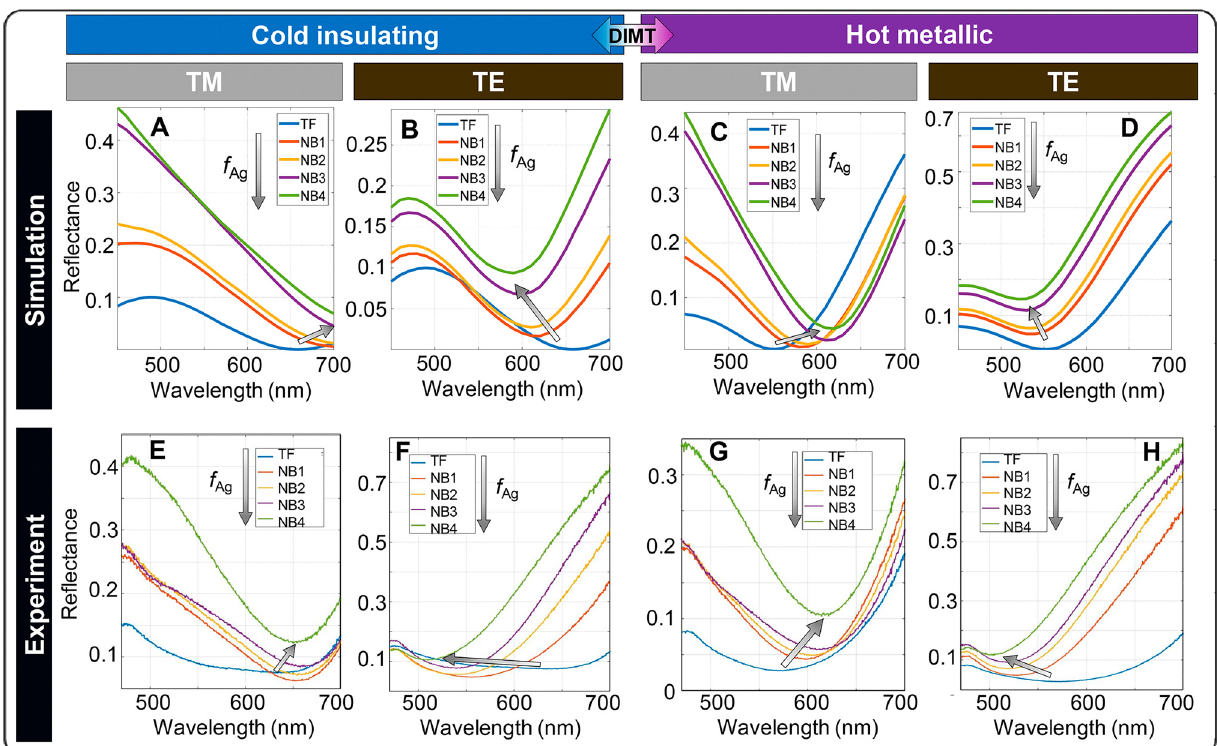
Figure 4: Effects of Ag nanobeams on the dynamic modulation range. Polarization and temperature dependent reflectance spectra of the PCMAs with varying f Ag (0, 0.17, 0.23, 0.34, 0.4) obtained from (A – D) simulations and (E – H) experiments. (A, B, E, F) present polarization dependent spectra at the cold insulating phase of VO 2 while (C, D, G, H) present those at the hot metallic phase of VO 2 . (A, C, E, G) and (B, D, F, H) show re fl ectance under TM and TE polarized normal illumination cases, respectively. The legend, TF, refers to the case of intrinsic thin fi lm VO 2 without Ag embedding (the Gires-Tournois VO 2 abosrber case when f Ag is zero). The direction of gradually colored arrows in (A-H) imply the increase of f Ag